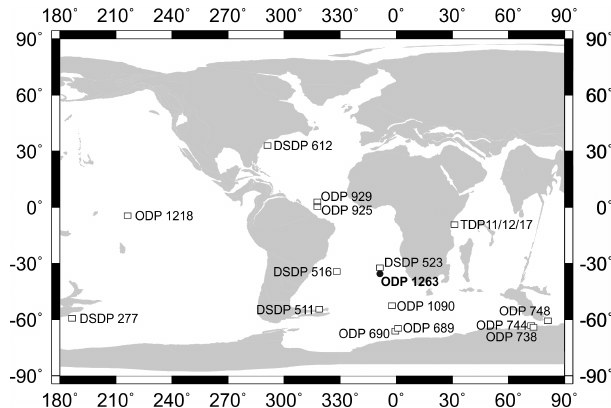
Figure 1. Paleogeographic reconstruction at 33Ma (modified from Ocean Drilling Stratigraphic Network, Plate Tectonic Recon- struction Service, www.odsn.de/odsn/services/paleomap/paleomap. html) showing location of ODP Site 1263 (black dot) on Walvis Ridge. The positions of the other sites (white squares) used for com- parison and cited in the text are also